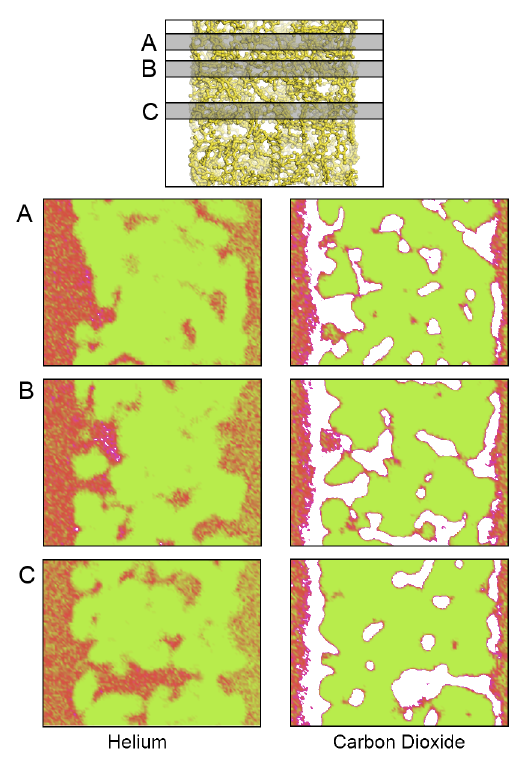
Figure 8. A density map showing the density of locations for the (left) He atoms and (right) CO molecules on an XZ projection calculated at three different Y slices: ( A ) 0.675; 2 ( B ) 1.275 and ( C ) 2.775 nm; from top to bottom, respectively. The plots show areas of high (white), average (red) and low (green) gas density. The top model shows the relative location of the polymer and the corresponding plane locations. Only a small fraction of the bulk fluid sections is depicted to the left and right of each plot. An animated version of this visualization can be found in the Supplementary